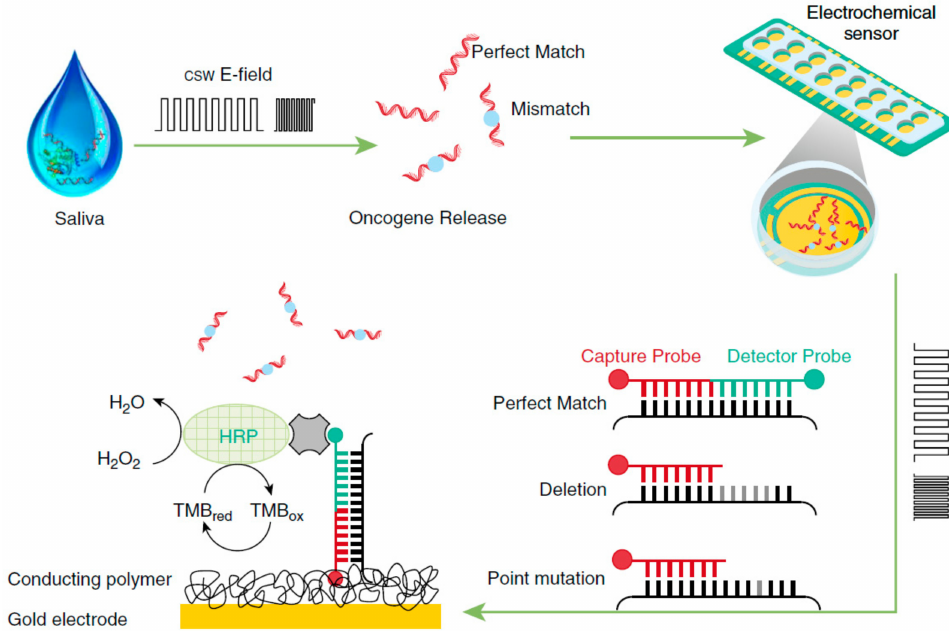
Figure 2. Multiplexed electrochemical sensor in connection with EFIRM technology for the determination of EGFR mutations in bodily fluids of patients with lung cancer. Reprinted from [21] with